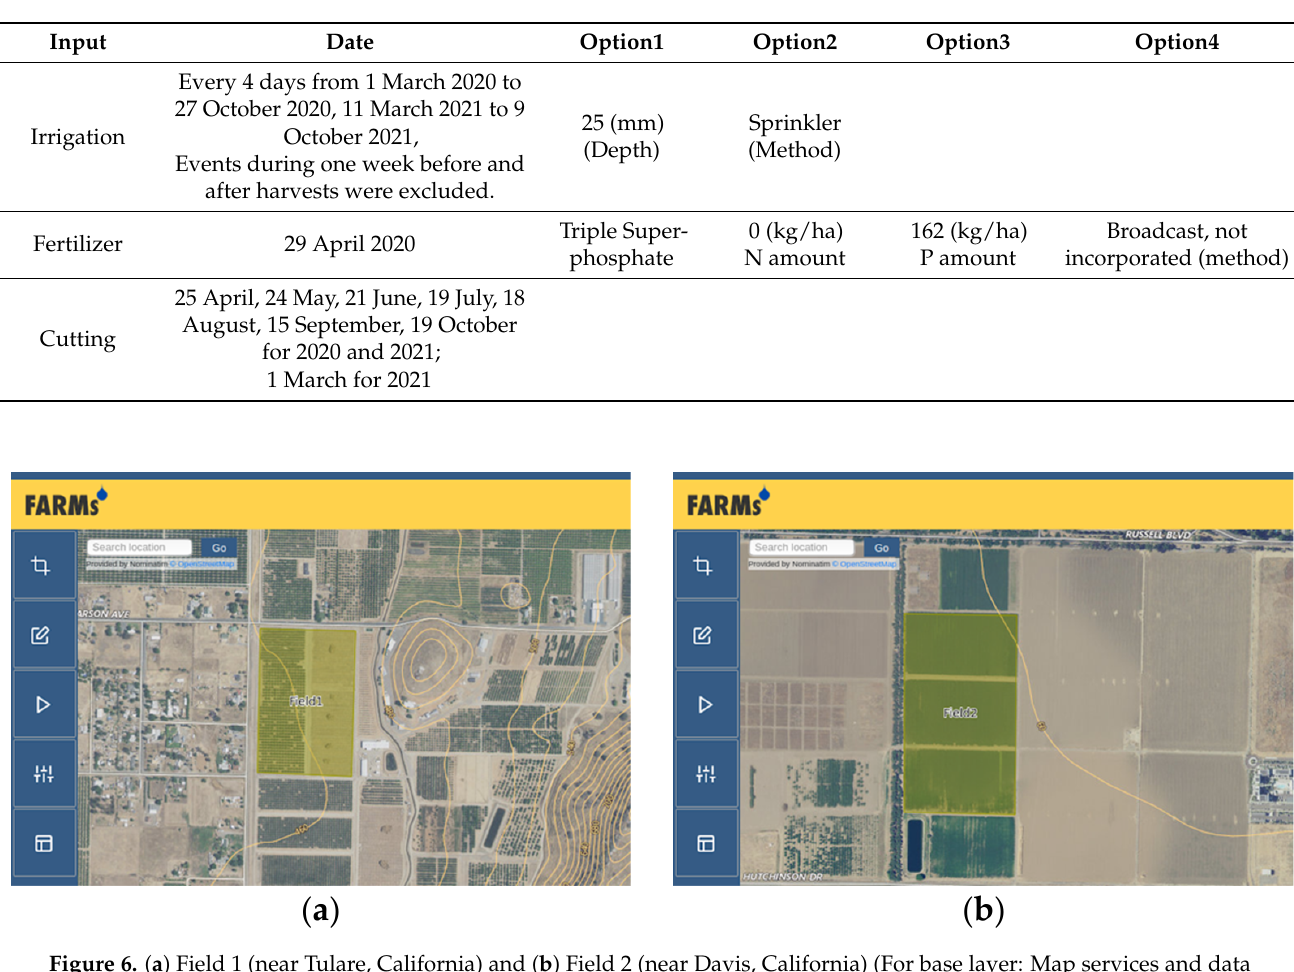
Figure 6. ( a ) Field 1 (near Tulare, California) and ( b ) Field 2 (near Davis, California) (For base layer: Map services and data available from U.S. Geological Survey, National Geospatial Program).